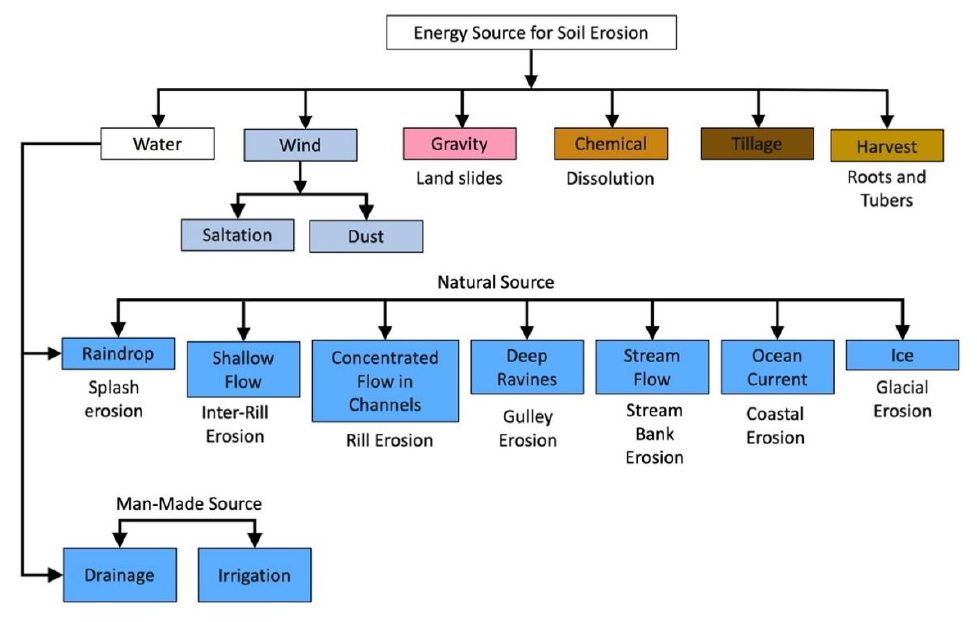
Figure 1. Types of soil erosion driven by source of energy.